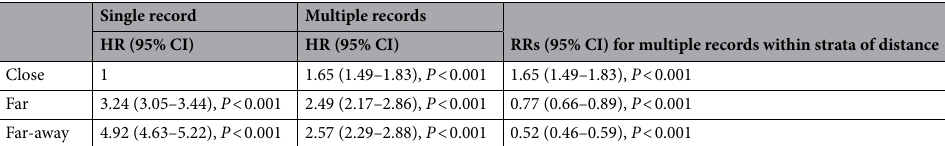
Table 5. Modification of the effect of transfer-out (multiple records) on LTFU by distance from the patient’s home to treatment centre. (1) Effect modification by distance ‘Far’. Measure of effect modification on additive of effect modification on additive scale: RERI (95% CI) = − 3.00 (− 3.43–− 2.57); P < 0.001. Measure of effect modification on multiplicative scale: ratio of RRs (95% CI) = 0.32 (0.27–0.37); P < 0.001. RRs are adjusted for age, gender, nationality, previous TB treatment history, location of TB and place of living. The ‘single record’ group represents patients who attend one treatment centre during a tuberculosis episode whereas the ‘multiple records’ group indicates those who attend multiple treatment centres (transfer-out). The distance ‘close’ applied to cases where the treatment centre and patient’s residence were within the same municipal level divisions (district, city, or county). ‘Far’ applied to cases where the treatment centre was in the different district, city or county but located within the same large administrative divisions (province or metropolitan city). ‘Far-away’ applied to cases where the treatment centre was located within the different large administrative